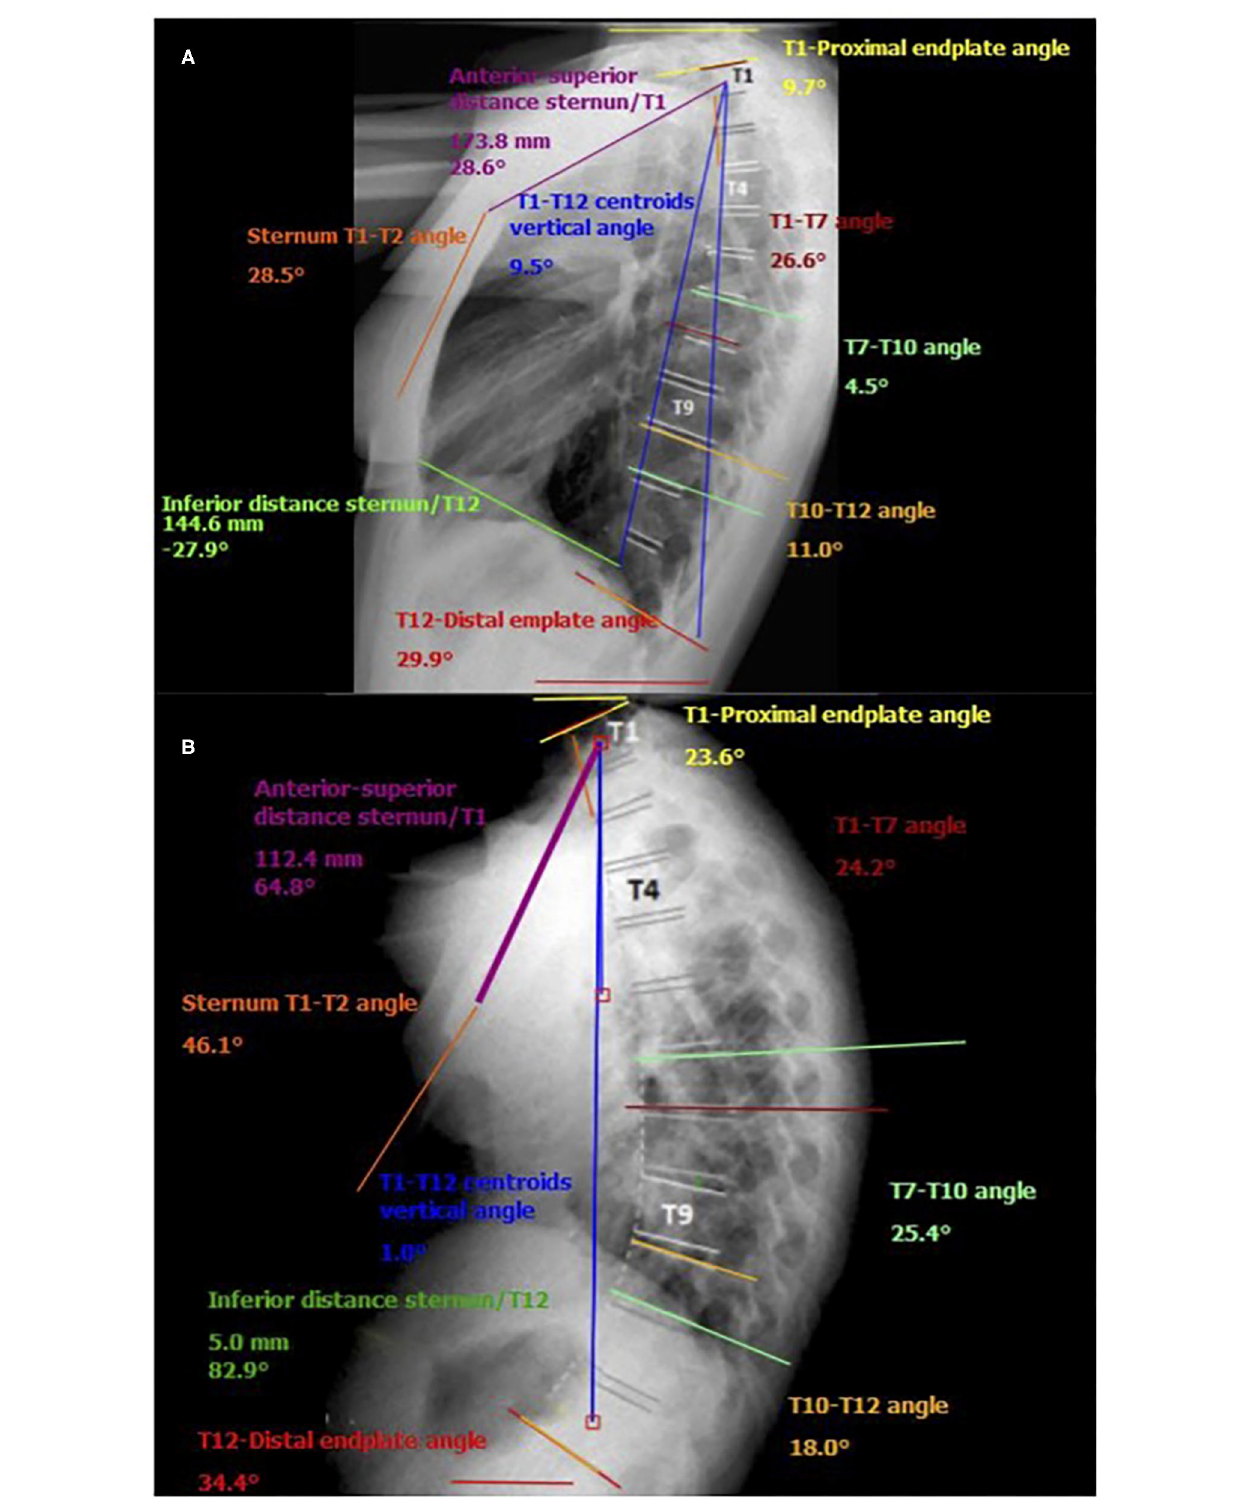
FIGURE 3 | Example of measurements taken by the surgimap software from the lateral radiographs of the thoracic spine in one of the participants. (A) forced inspiration; (B) forced exhalation.